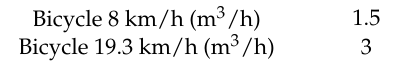
Table 2. Ventilation rate corresponding to a bicycle speed of 8 km/h and 19.3 km/h